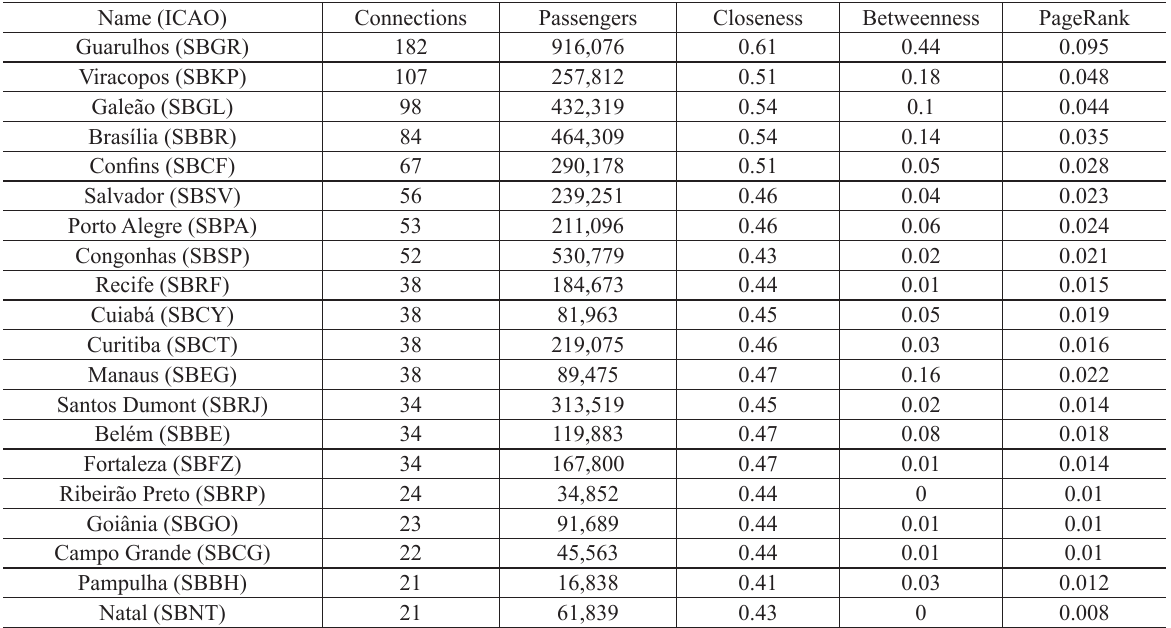
Top-20 Brazilian Airports - Number of Connections - National and International Flights.